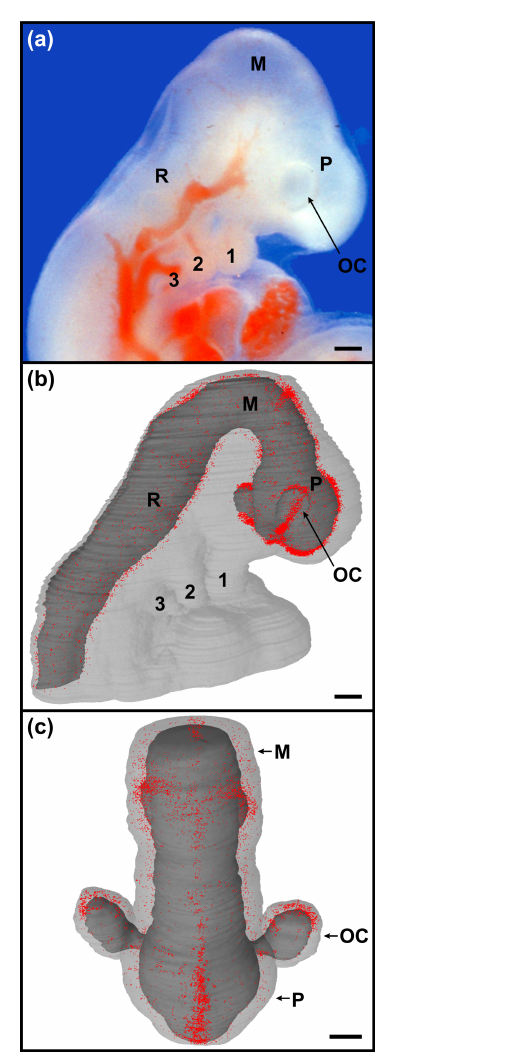
Figure 16. 3-D reconstruction of apoptotic cells in the brain of a 15- day-old embryo of Tupaia belangeri , serial section alignment done with “hybrid sections”. (a) Photograph of the unsectioned translu- cent embryo revealing red colored blood cells in developing vessels and heart. M, mesencephalon; OC, optic cup; P, prosencephalon; R, rhombencephalon; 1, 2, 3, branchial arches 1–3. (b, c) 3-D re- construction built up from semithin sections (1µm) demonstrates the surface ectoderm (transparent light gray), the inner margin of the neuroepithelium (dark gray), and individually marked apoptotic bodies (red dots). Lateral (b) and frontal (c) views reveal a band of apoptotic cells extending from the dorsal midline of the mes- and prosencephalon to the ventral midline of the prosencephalon and, bilaterally symmetrically, to the optic cups. Note horizontal apop- totic bands at the transition from mes- to prosencephalon. Scale bars = 200µm. Reprinted from Knabe et al. (2002, Fig. 5). © 2002, with permission from